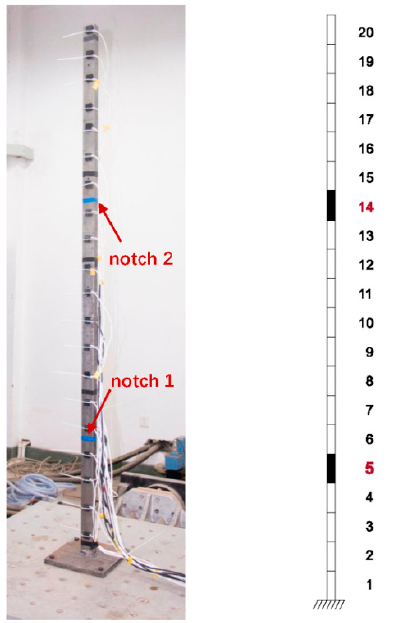
Figure 19. Beam structure used in the experiment, physical ( left ) and finite element ( right ) models.